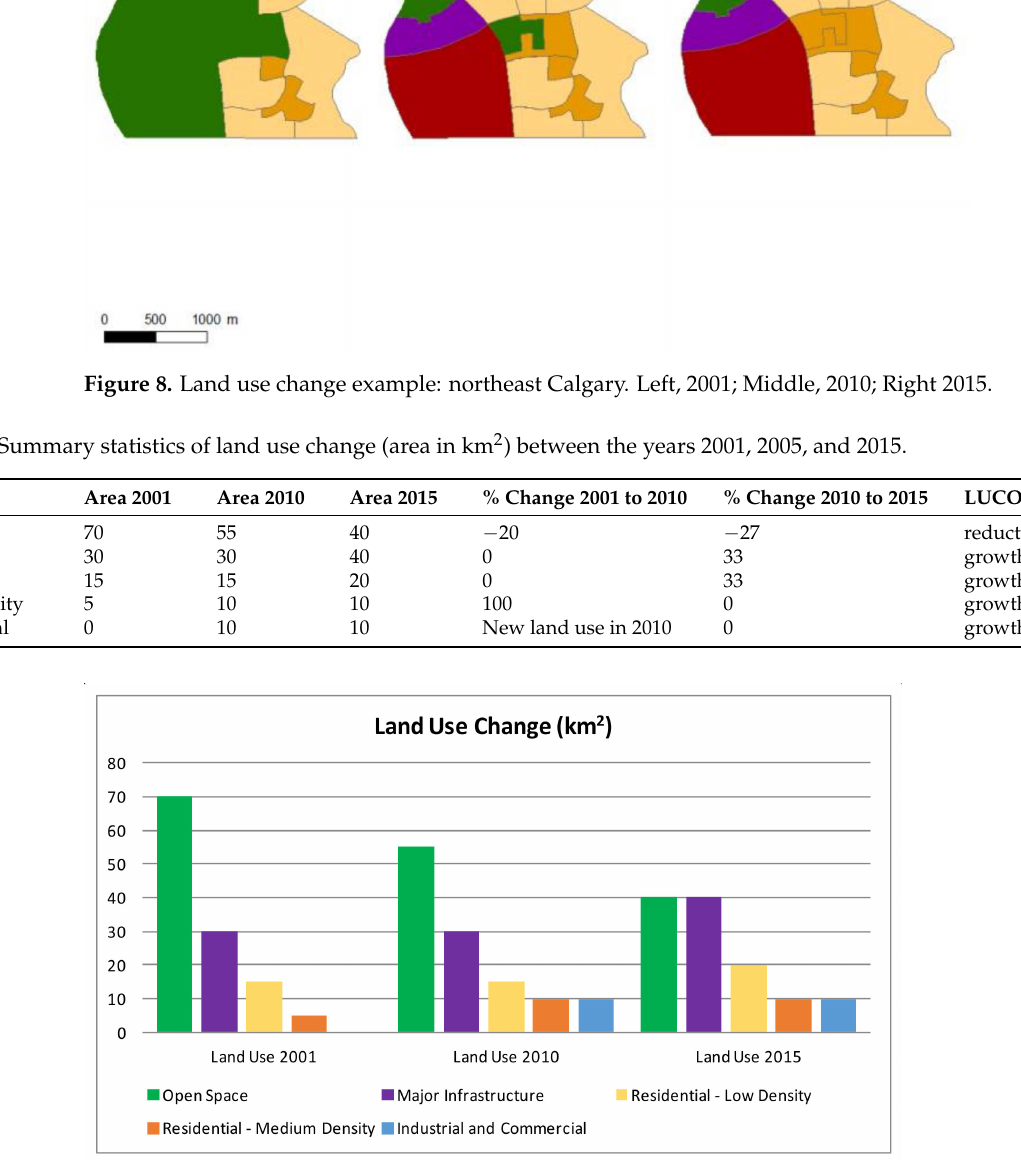
Figure 9. Land use change from